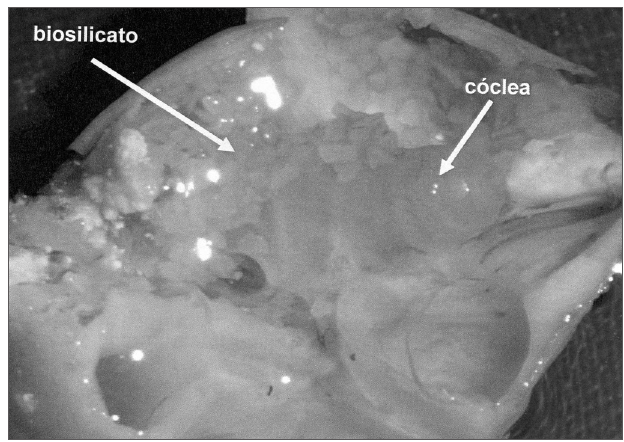
Figure 1. Lab animal cochlea with powder otosilicate around the cochlea and round window. The animals were slaughtered in a